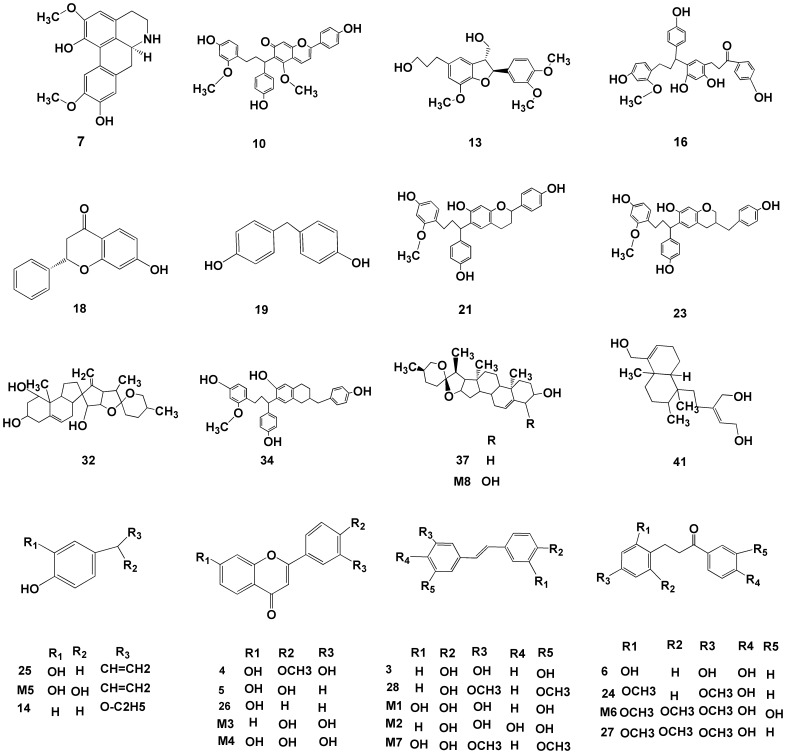
The structures of the 20 potentially absorbed DB constituents and 8 metabolites.
3. 3,5,4′-trihydroxystilbene; 4. 4′-methoxy-3′7-dihydroxyflavan; 5. 7,4′-dihydroxyflavan; 6. 2,4,4′-trihydroxydihydrochalcone; 7. norisoboldine; 10. dracaenin A; 13. 3,4-o-dimethylcedrusin; 14. ethyl 4-hydroxybenzoate; 16. cochinchinenin; 18. (2S)-7-hydroxyflavanone; 19. 4,4′-dihydroxydiphenylmethane; 21. homoisosocotrin-4-ol; 24. loureirin A; 25. 3,4-dihydroxy-allylbenzene; 26. 7-hydroxyflavanone; 27. loureirin B; 28. pterostilbene; 32. dracaenol B; 34. cochinchinenin E; 37. diosgenin; 41. bincatriol. M1 and M2 were metabolites of compound 3; M3, M4, M5, M6, M7, and M8 were metabolites of compounds 4, 5, 25, 27, 28, and 37, respectively.